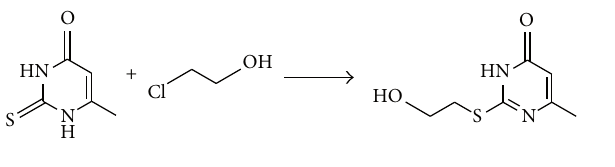
F 6: Syntheses of sodium salt of 2,3-dihydro-6-methyl-2- thioxopyrimidin-(1 H )-one